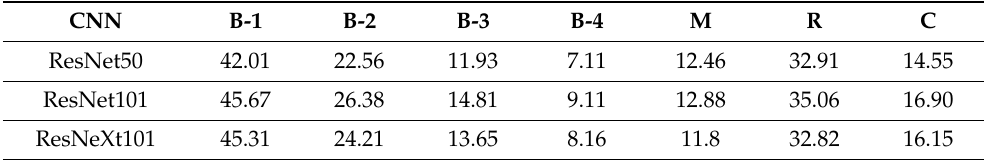
Table 2. Performance on test splits for Baseline-A model.